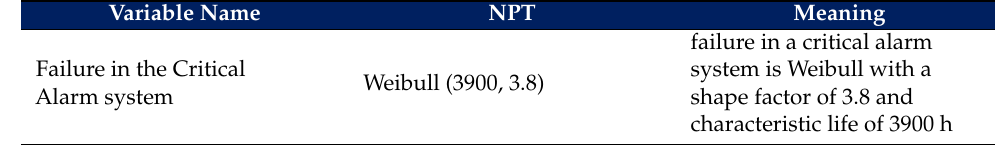
Table 8. NPT of the variables describing resilience